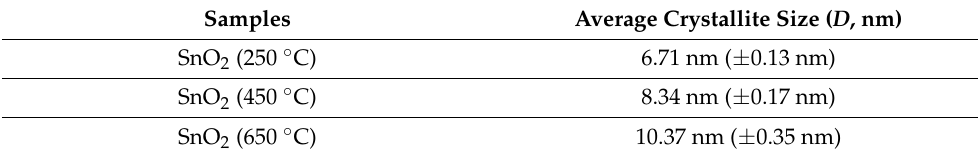
Table 1. Crystallite size of SnO 2 nanoparticles calcined at 250 ◦ C, 450 ◦ C, and 650 ◦